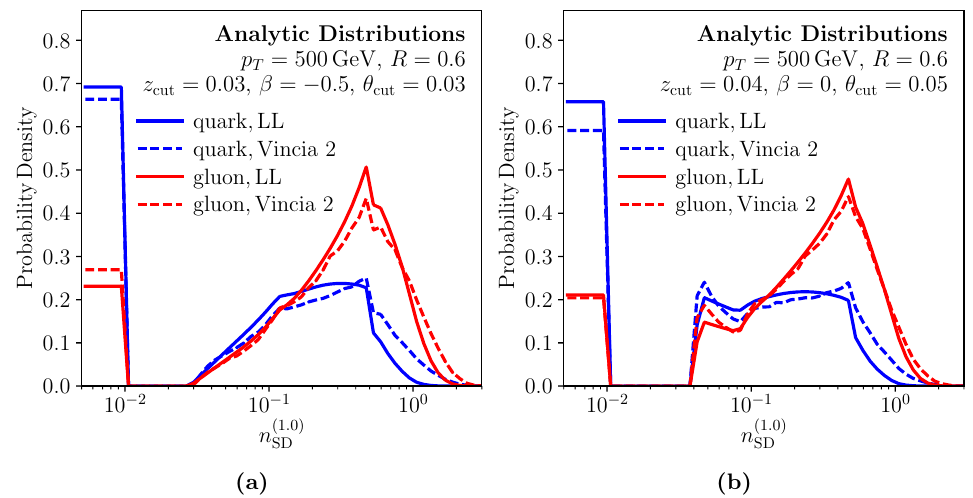
Figure 20. LL calculation of weighted soft drop multiplicity distributions with (cid:20) = 1, compared to Vincia . The plots have two di(cid:11)erent sets of ISD parameters which were chosen to display the sharp features characteristic of n ( (cid:20) ) in the perturbative regime. The curves shown are the SD probability distribution functions of log n (1 : 0) , so that they integrate to one in logarithmic space. SD The leftmost bin is an under(cid:13)ow bin, showing the probability that no emissions were counted by ISD, such that n (1 : 0) = SD